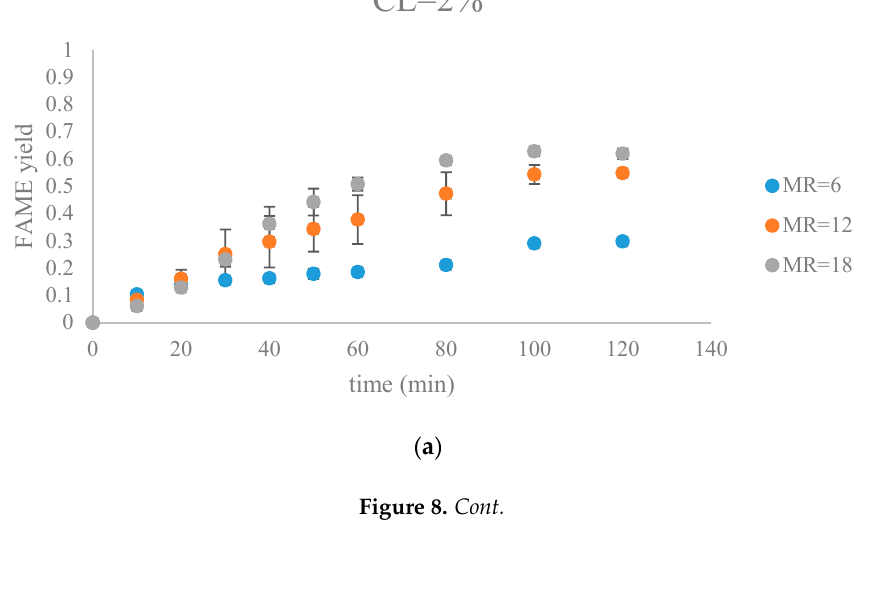
Figure 7. The fatty acid methyl ester (FAME) yield with the progress of the soybean oil transesterification catalyzed by Na-COS grouped by molar ratio of methanol to oil (MR) ( a ) MR = 6; ( b ) MR = 12; ( c ) MR = 18.